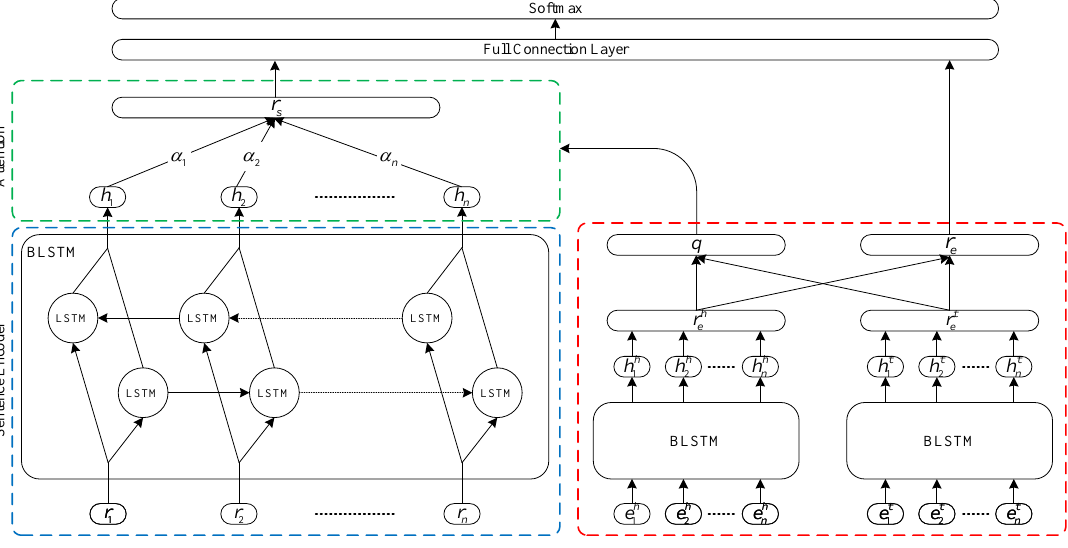
and e t is the i i